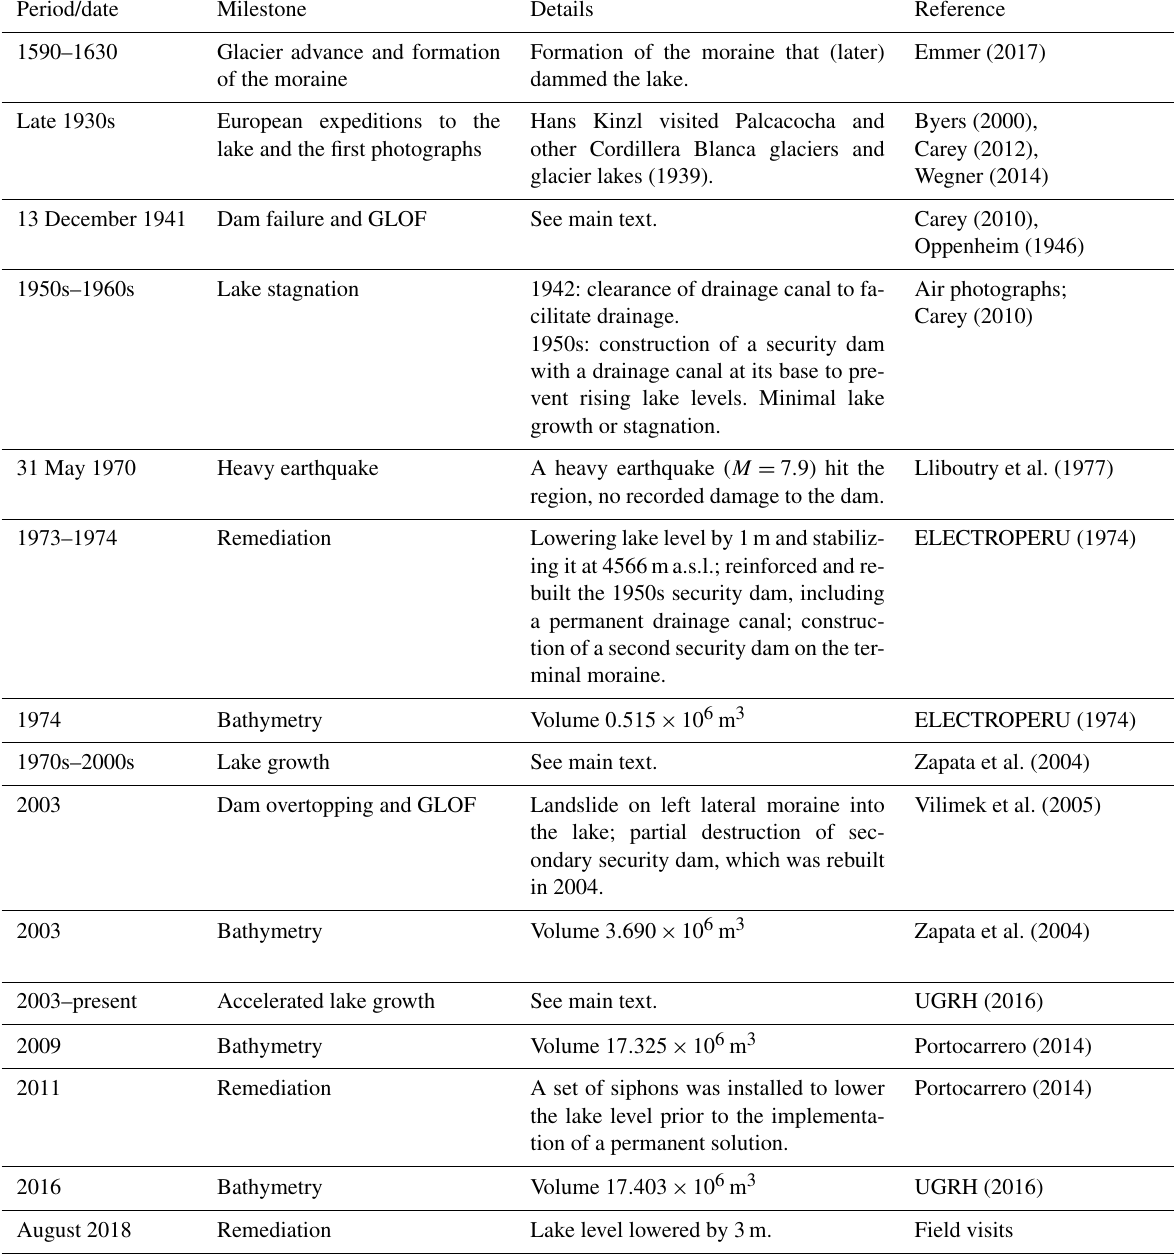
Table 1. Milestones in the evolution of lake